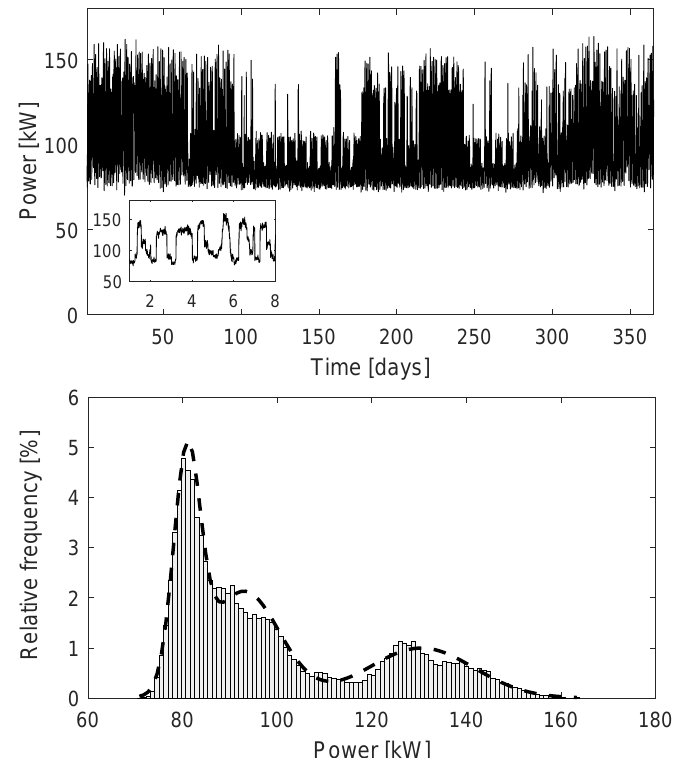
Figure 3. Example of yearly load profile (with 1-week zoom in the inset) and corresponding histogram at bus no. 2, when the load variations are bounded within ± 60%. The dashed line fitting the histogram is the probability density function of a Gaussian Mixture Model (GMM) consisting of three components with mean values: 80.9, 93, 130.5 kW; standard deviations: 8.0, 56.5 and 123.4 kW and mixing factors: 0.32, 0.40 and 0.28,